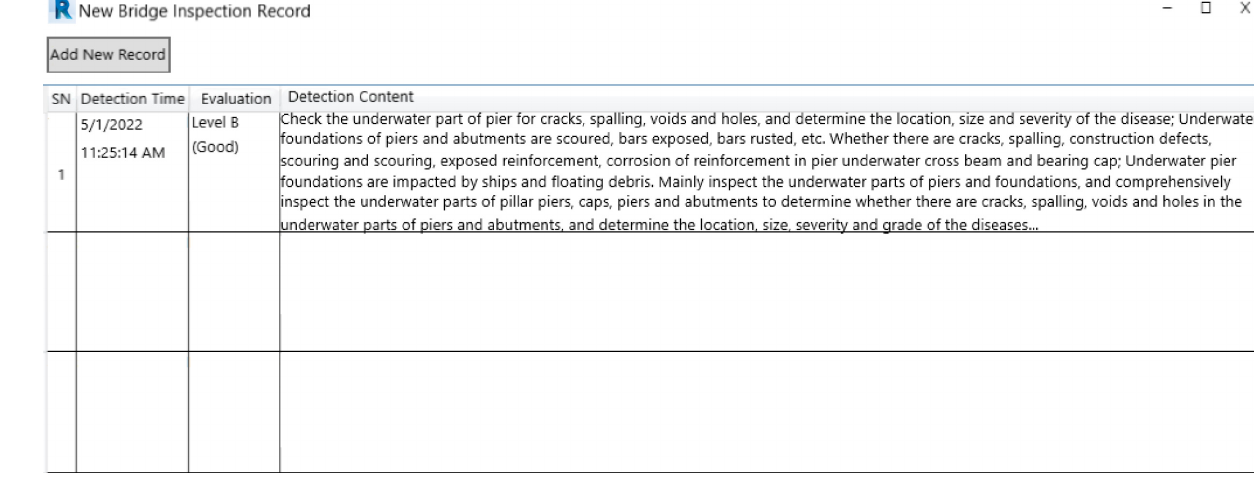
Figure 16. Graph Check Record Table.